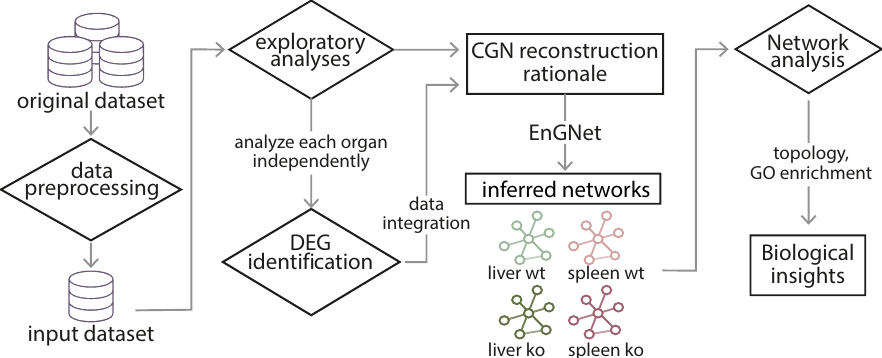
Figure 1. General scheme for the reconstruction method. The preprocessed data was subjected to exploratory and differential expression analyses, which imposed the reconstruction rationale. Four groups of samples were used to generate four independent networks, respectively modeling the immune response in the liver, both in the wt and the ko situations; and in the spleen, also in the wt and the ko